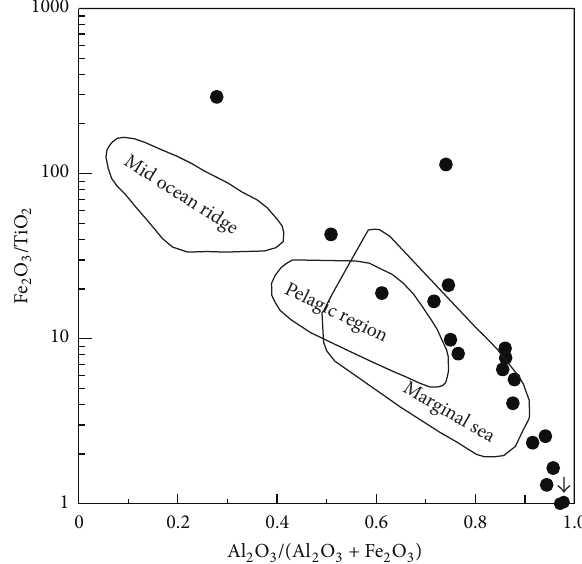
Figure 11: Major element discrimination diagram indicating biolog- ical and volcanic processes for the genesis of the Bafangshan-Erlihe area (After-[56]).